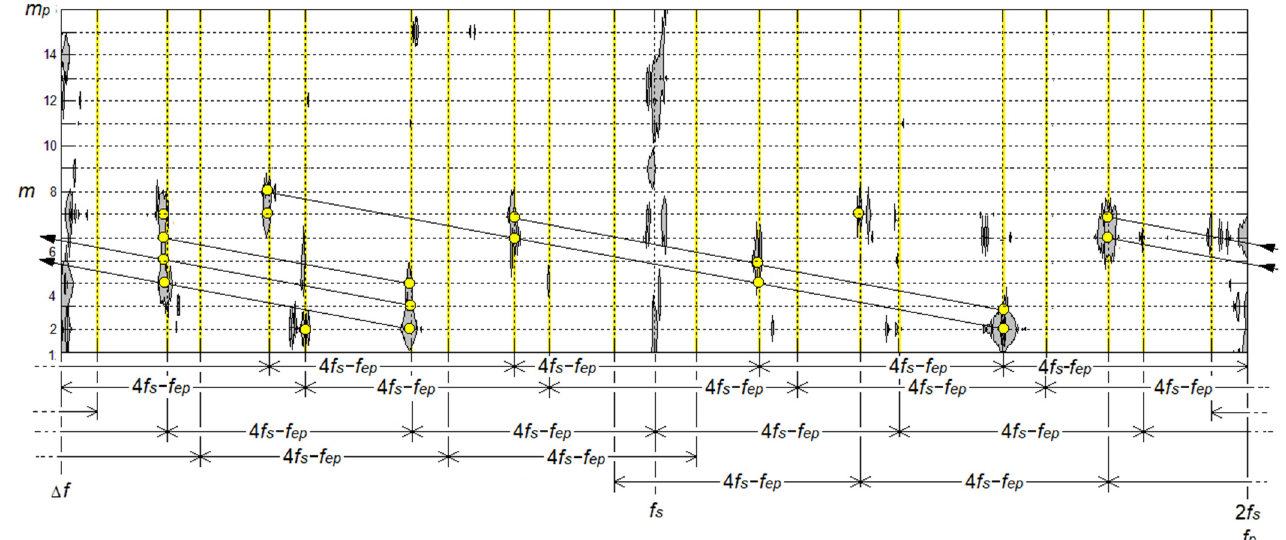
Figure 13. F-F image of the frequency spectrum of the vibration acceleration of the motor’s outer casing with the bearing slackness ( f P = 2 f s ) reduced to the low frequency range. casing with the bearing slackness ( f P = 2 f s ) reduced to the low frequency